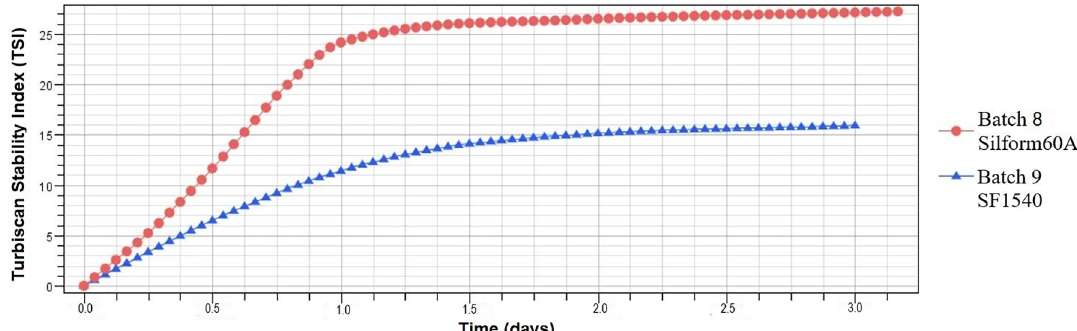
Figure 3. Kinetic-stability comparison of Batch 8 and Batch 9.